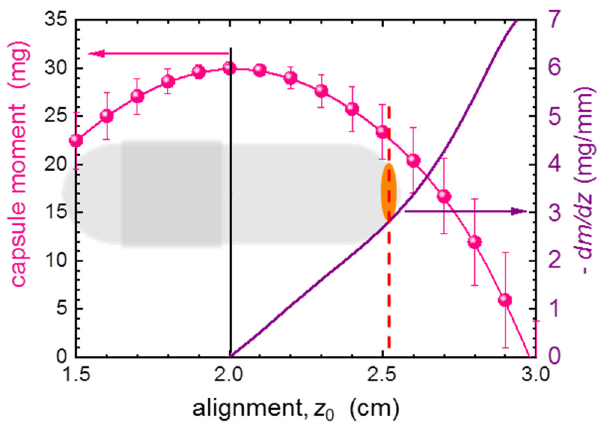
Figure 4. The position dependence of the magnetic moment calculated from a scan of a typical #5 capsule (30 mg of mass) expressed as the corresponding mass (pink bullets). The magnitude of this change defines the absolute value of the misalignment error with respect to the center position (a black vertical line at z 0 = 2.0 cm). The purple solid line yields the derivative of the former, that is the magnitude of the uncertainty due to the misalignment. The sketch of a #5 capsule at the background brings a sense of the real scale. The orange oval mimics a small object of investigation residing at the bottom of the capsule at the position marked by a dashed red line.